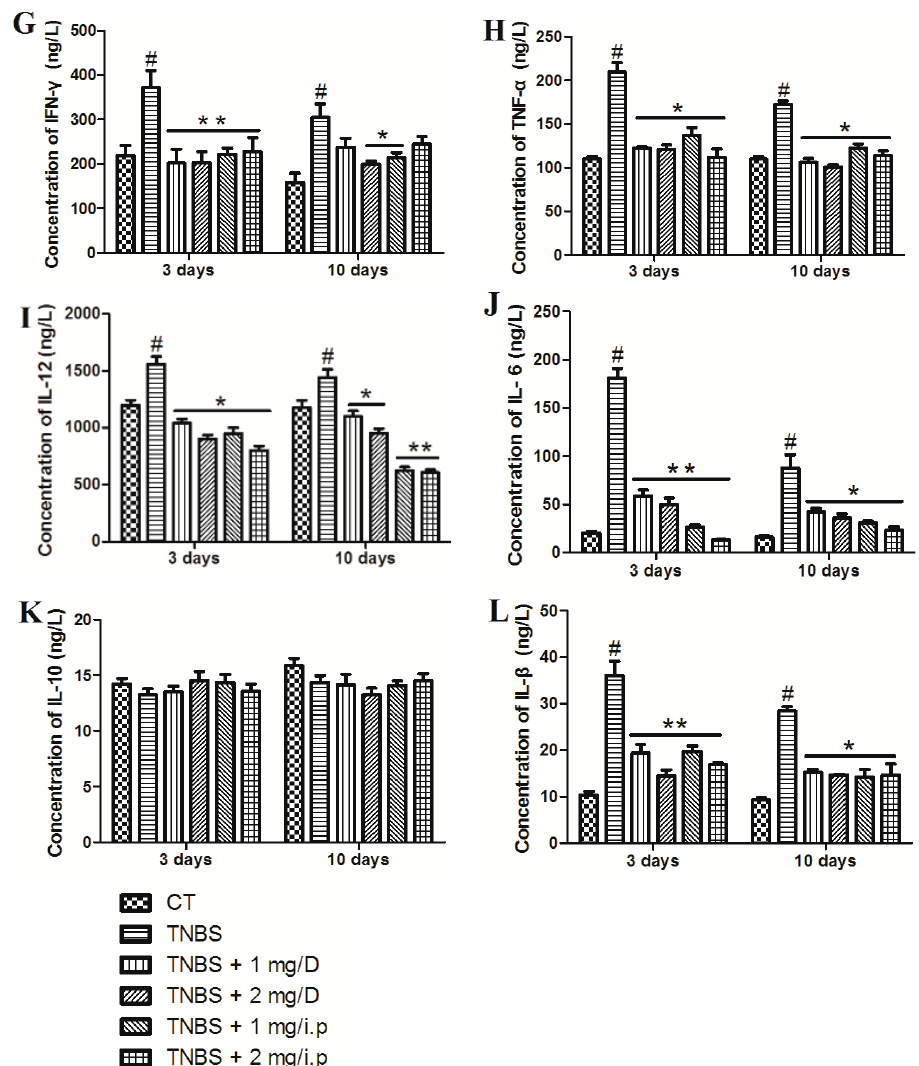
Figure 3. Effects of MMF on cytokine production in the serum and colon tissue samples of colitic